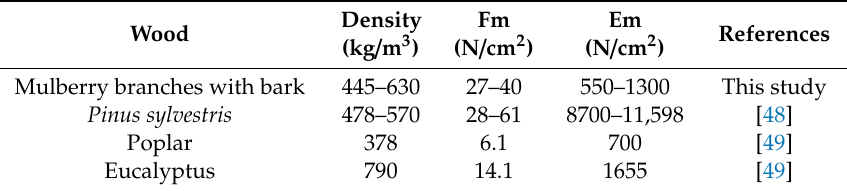
Table 1. Properties of mulberry wood, Scots pine, poplar and eucalyptus.